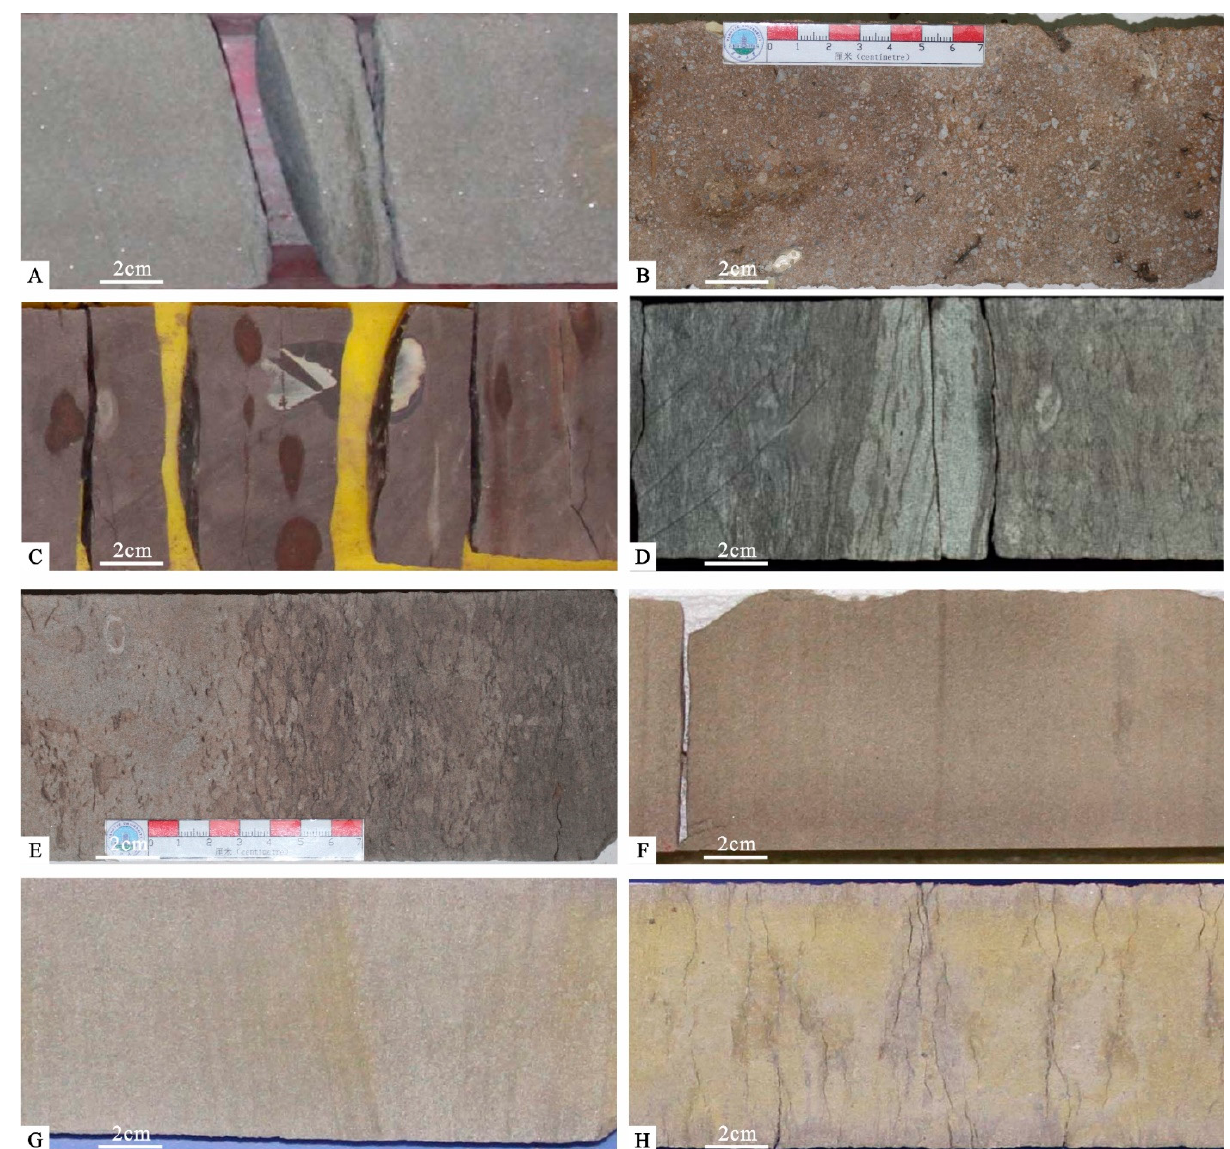
Figure 3. Lithologic characteristics and sedimentary structures in the Zhujiang Formation of Pearl River Mouth Basin, northern South China Sea: ( A ) The core shows grey medium-coarse sandstone with tabular cross bedding in well P6 (2771.4 m). ( B ) The core shows red-brown gravelly medium-coarse sandstone with massive bedding in well P1 (3349.3 m). ( C ) The core shows red-brown mudstone with iron nodules and horizontal bedding in well P1 (3345 m). ( D ) The core shows grey silt-stone-fine sandstone with small cross bedding in well P2 (3304.4 m). ( E ) The core shows gray siltstone-fine sandstone with reverse grain sequence characteristics, biological disturbance, and horizontal wormholes in well P2 (3305.5 m). ( F ) The core shows red-brown fine sandstone with parallel bedding in well B4 (3741 m). ( G ) The core shows yellow-gray fine sandstone with wedge cross bedding in well B4 (3755 m). ( H ) The core shows yellow-gray fine sandstone with shaly strip deformation structure in well B4 (3732.1 m).